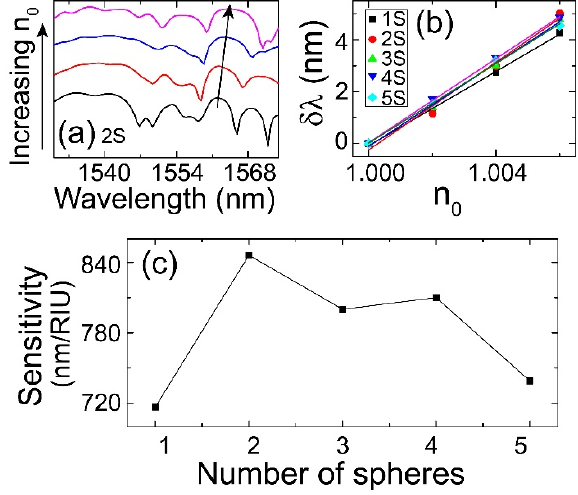
Figure 6. ( a ) The transmission spectrum shift of taper-assisted two microspheres (2S) as an example as increasing the surrounding refractive index (n 0 ). ( b ) The wavelength shifts of 5 proposed sensors versus the changes of surrounding RI. ( c ) The sensitivity comparison of 5 proposed sensors, simply signed as number of spheres.